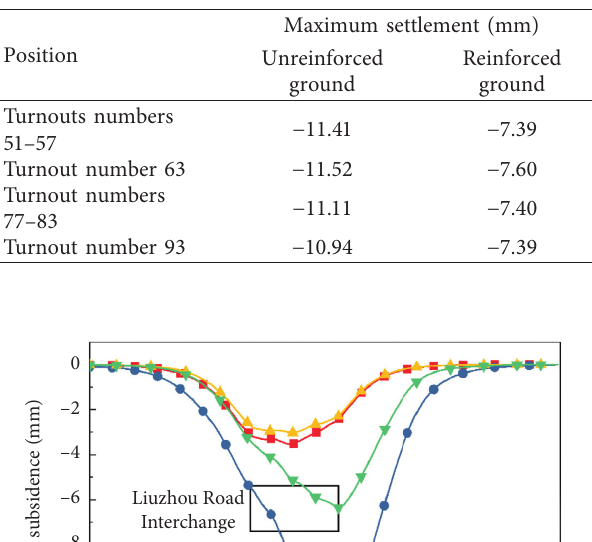
Table 4: FEM simulation results with and without ground improvement.